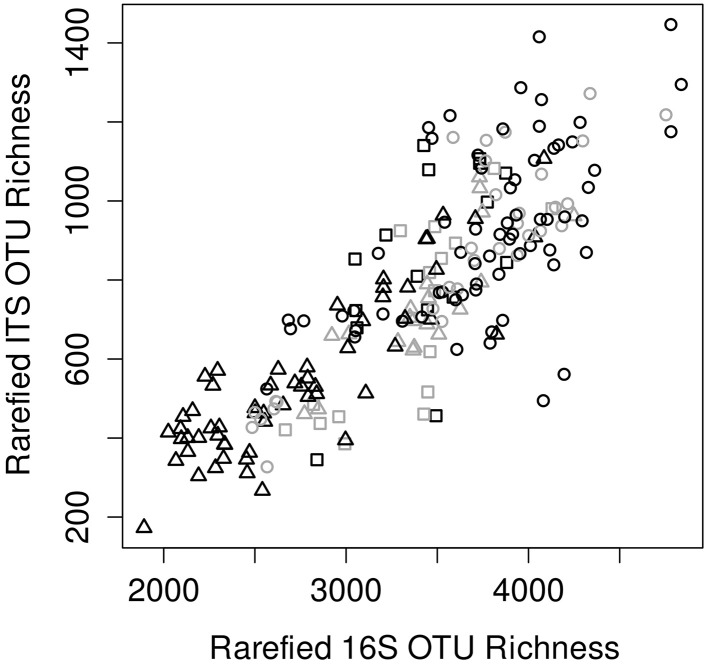
Comparison of prokaryotic (16S) vs. fungal (ITS) rarefied richness estimates between samples. Valley samples are symbolized by circles, low mountain by squares and high mountain by triangles. Samples with siliceous bedrock are colored black while those from calcareous are colored gray.